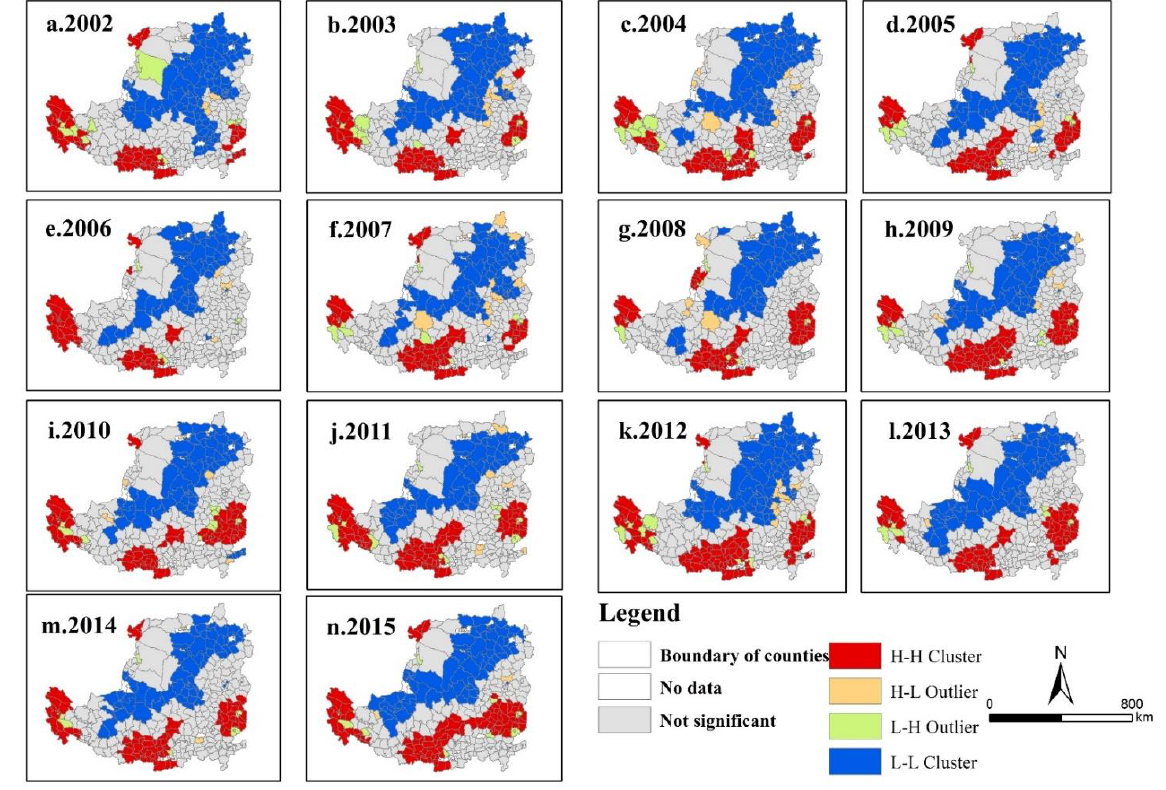
Figure 8. The LISA cluster distribution of EEoSLCP, 2002 to